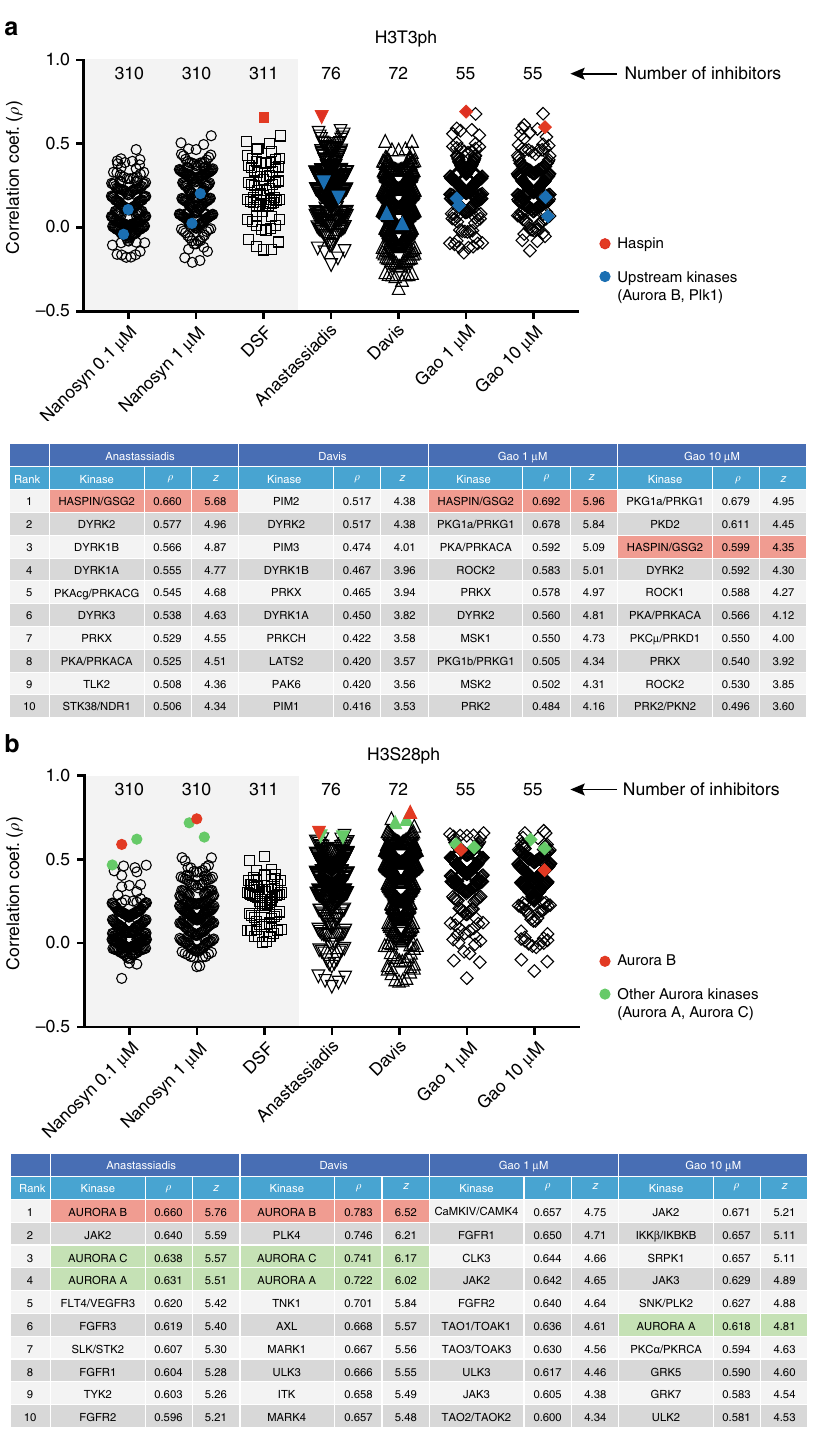
Fig. 5 Results of KiPIK screens using the custom inhibitor library. a KiPIK screen for H3T3ph. Stripcharts show the Pearson correlation coef fi cients of the %inhibition results from the KiPIK screen against the %inhibition results for each of the kinases in the Anastassiadis, Davis and Gao (1 and 10 µ M) pro fi ling datasets. Results from the PKIS1 screen using Nanosyn and DSF datasets are shown for comparison (shaded gray). The number of inhibitors included in each dataset is indicated above the plot. The table below shows the top 10 hits from each pro fi ling dataset with corresponding correlation coef fi cients and z -scores. The expected kinase (Haspin/GSG2) is shown in red, and kinases that are known to indirectly modulate H3T3ph are shown in blue. b KiPIK screen for H3S28ph. Scatterplots and the table below are as indicated in ( a ). Expected kinase(s) are shown in red, and closely related kinases in green. Source data are provided as a Source Data fi